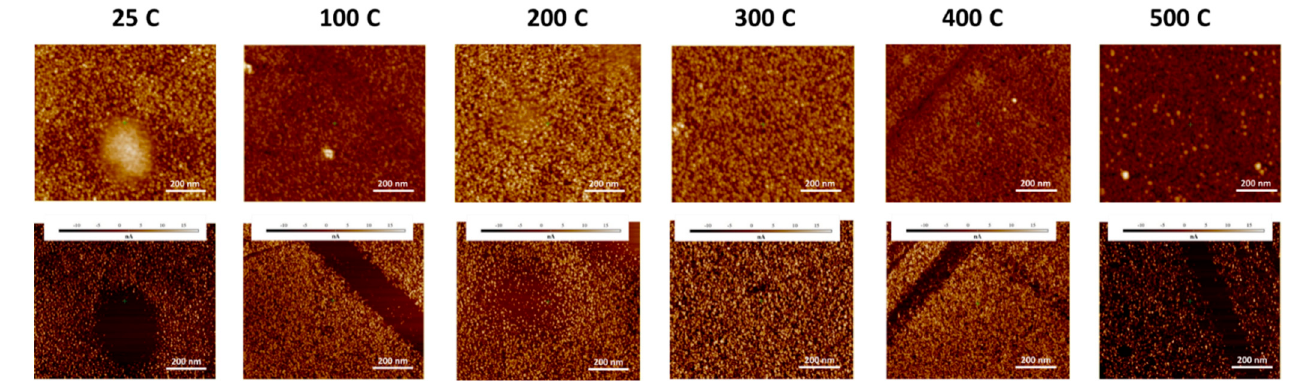
Figure 6. AFM height ( top ) and current ( bottom ) micrographs of Mo films at different pressures.